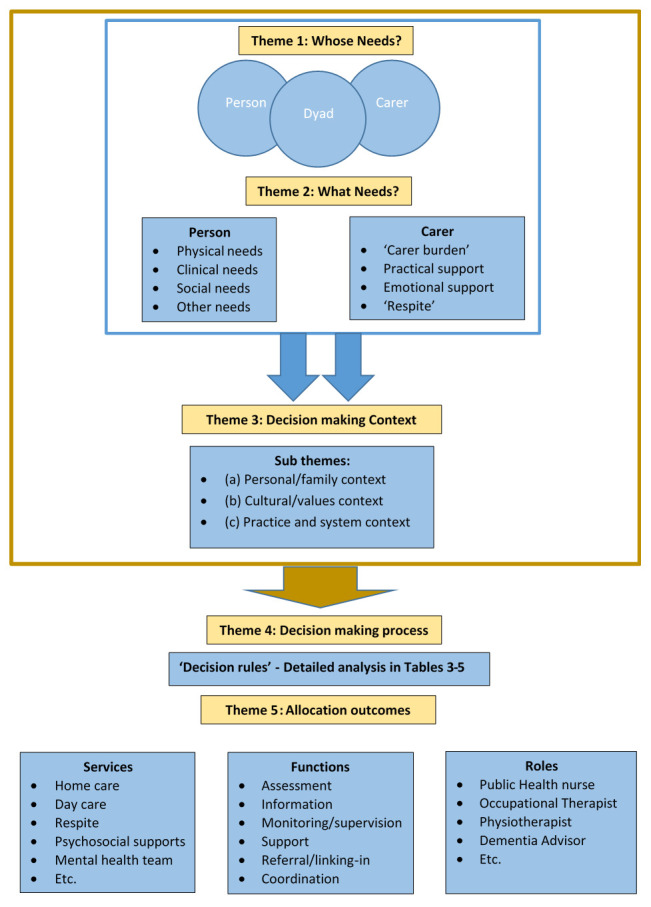
Thematic framework.